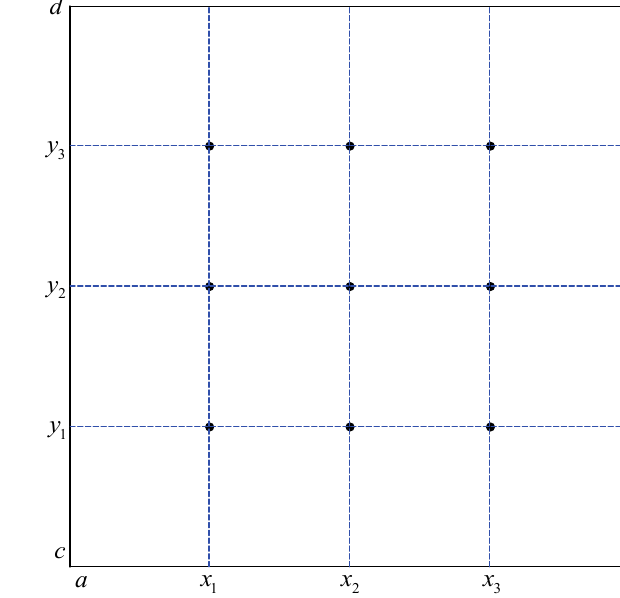
Fig. 3. Examples of when probing only two-by-two internal points leads to cutting off the subrectangle containing the least value of a surface on a given rectangle (the surface value is proportional to the circle size, and the least value is marked by square; the area which is cut off is darkened).